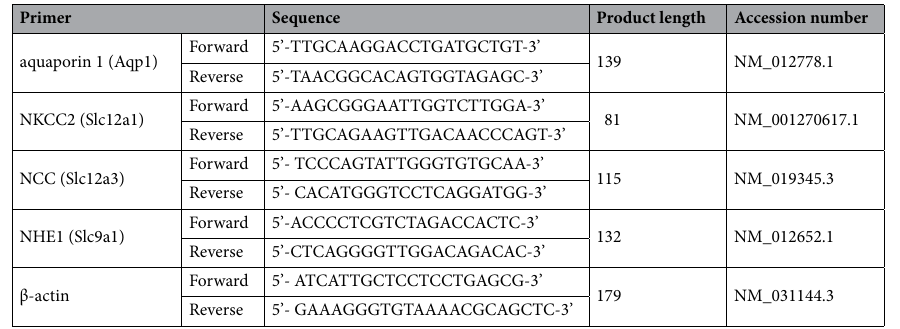
Table 3. Used oligonucleotide primers in the present study for RT-PCR